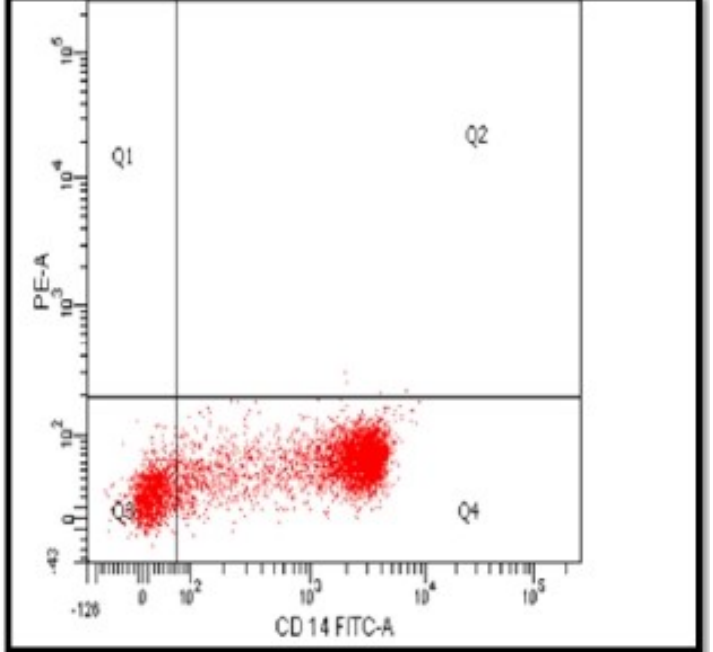
phycoerythrin; FITC ‐ A, fluorescein isothiocyanate; Q1, quadrant 1; Q2, quadrant 2; Q3, quadrant 3;